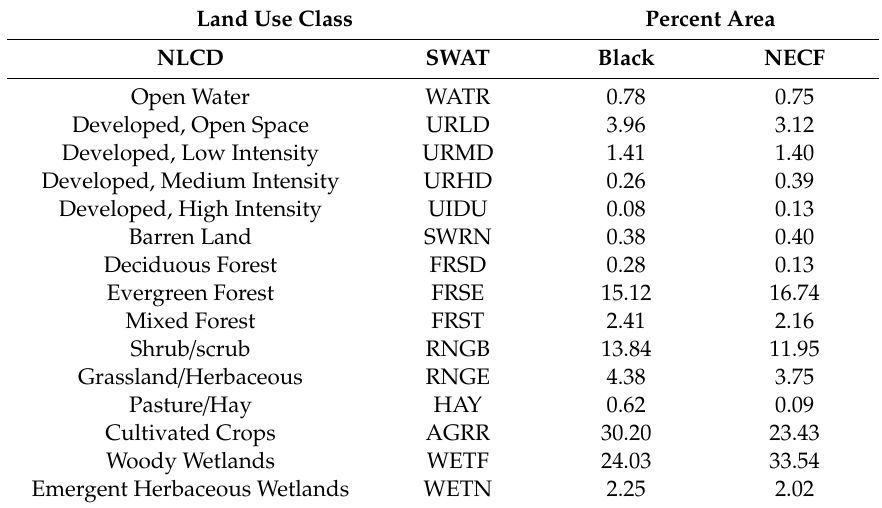
Table 1. National Land Cover Dataset (NLCD) with the corresponding Soil and Water Assessment Tool (SWAT) land-use classes in the Black and Northeast Cape Fear